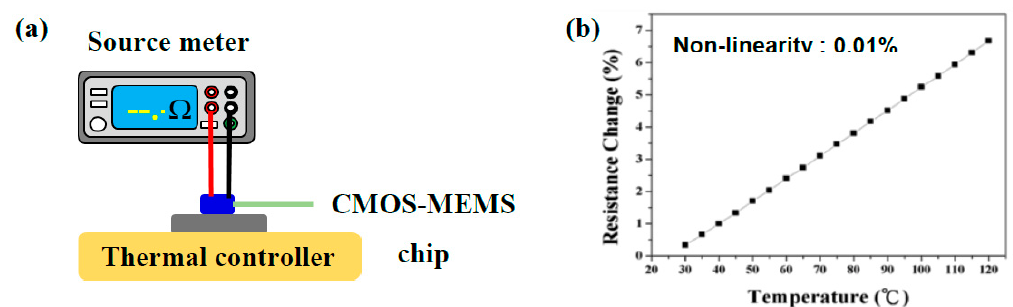
Figure 5. ( a ) The test setup, and ( b ) measurement results, for the resistance change versus temperature.